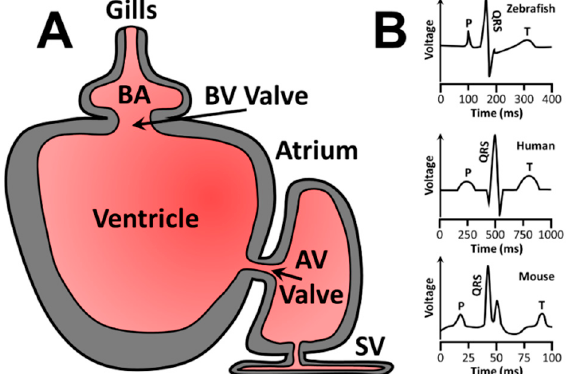
Figure 1. Zebrafish cardiac circulation diagram and representative ECG for zebrafish, humans, and mice. ( A ) Zebrafish cardiac circulation begins at the sinus venosus (SV), enters the atrium, passes through the atrioventricular (AV) valve, fills the ventricle, and is pushed through the bulbo-ventricular (BV) valve into the bulbus arteriosus (BA) before reaching the gills for oxygenation. ( B ) Representative ECGs of zebrafish (top), humans (middle), and mice (bottom). Human ECGs are more similar to zebrafish than mouse ECGs. P = p wave, or atrial depolarization. QRS = QRS complex or atrial repolarization combined with ventricle depolarization. T = T wave or ventricular repolarization.